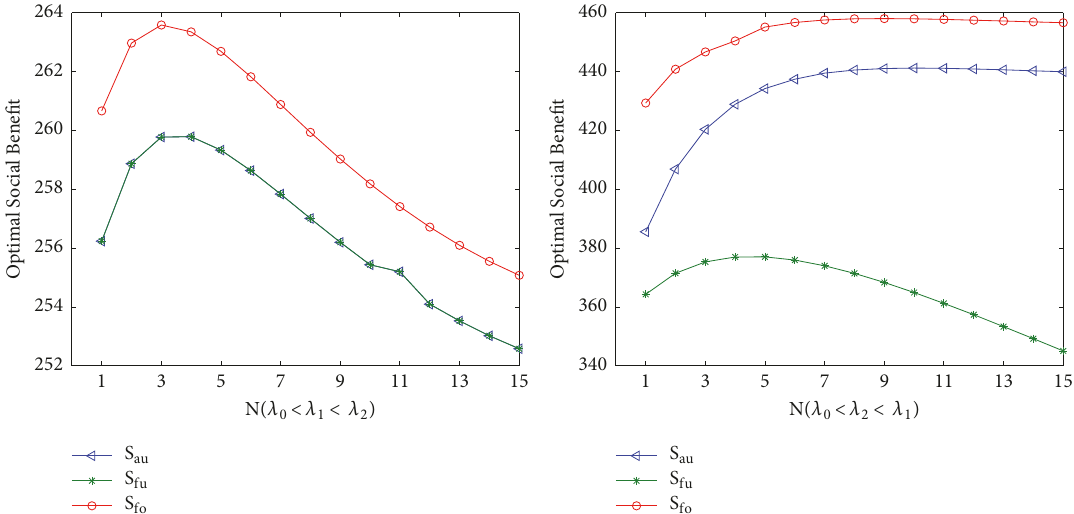
Figure 11: Left: optimal social benefit under three different information levels vs. 𝑁 ( 𝜆 0 < 𝜆 1 < 𝜆 2 ) for 𝑅 = 30, 𝐶 1 = 15, 𝐶 2 = 10, 𝜆 1 = 10, 𝜆 0 = 8, 𝜆 2 = 13. Right: optimal social benefit under three different information levels vs. 𝑁 ( 𝜆 0 < 𝜆 2 < 𝜆 1 ) for 𝑅 = 30, 𝐶 1 = 20, 𝐶 2 = 15, 𝜆 1 = 20, 𝜆 0 = 16, 𝜆 2 =